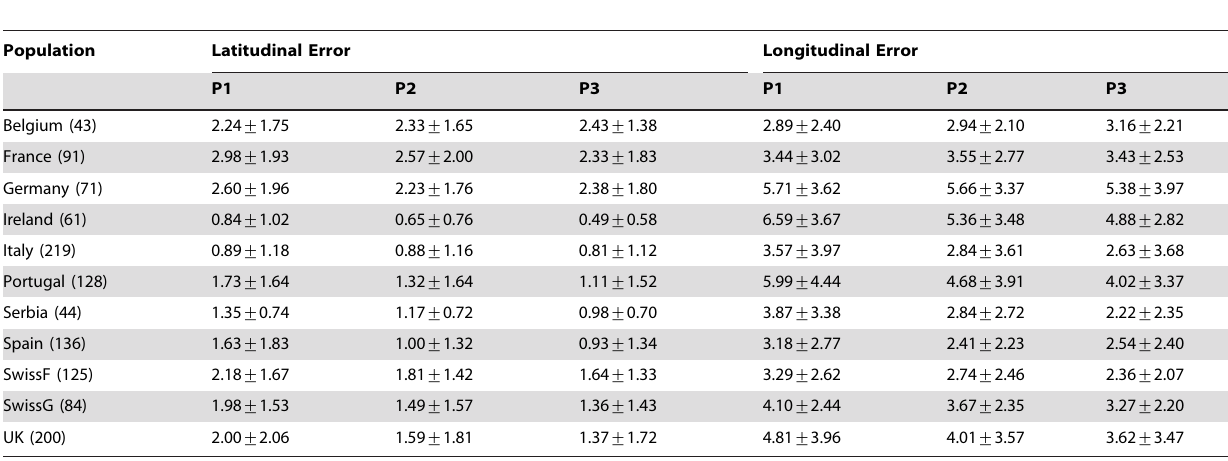
Table 1. Latitudinal and longitudinal errors of our full leave-one-out validation experiment on 1,200 samples from 11 populations.